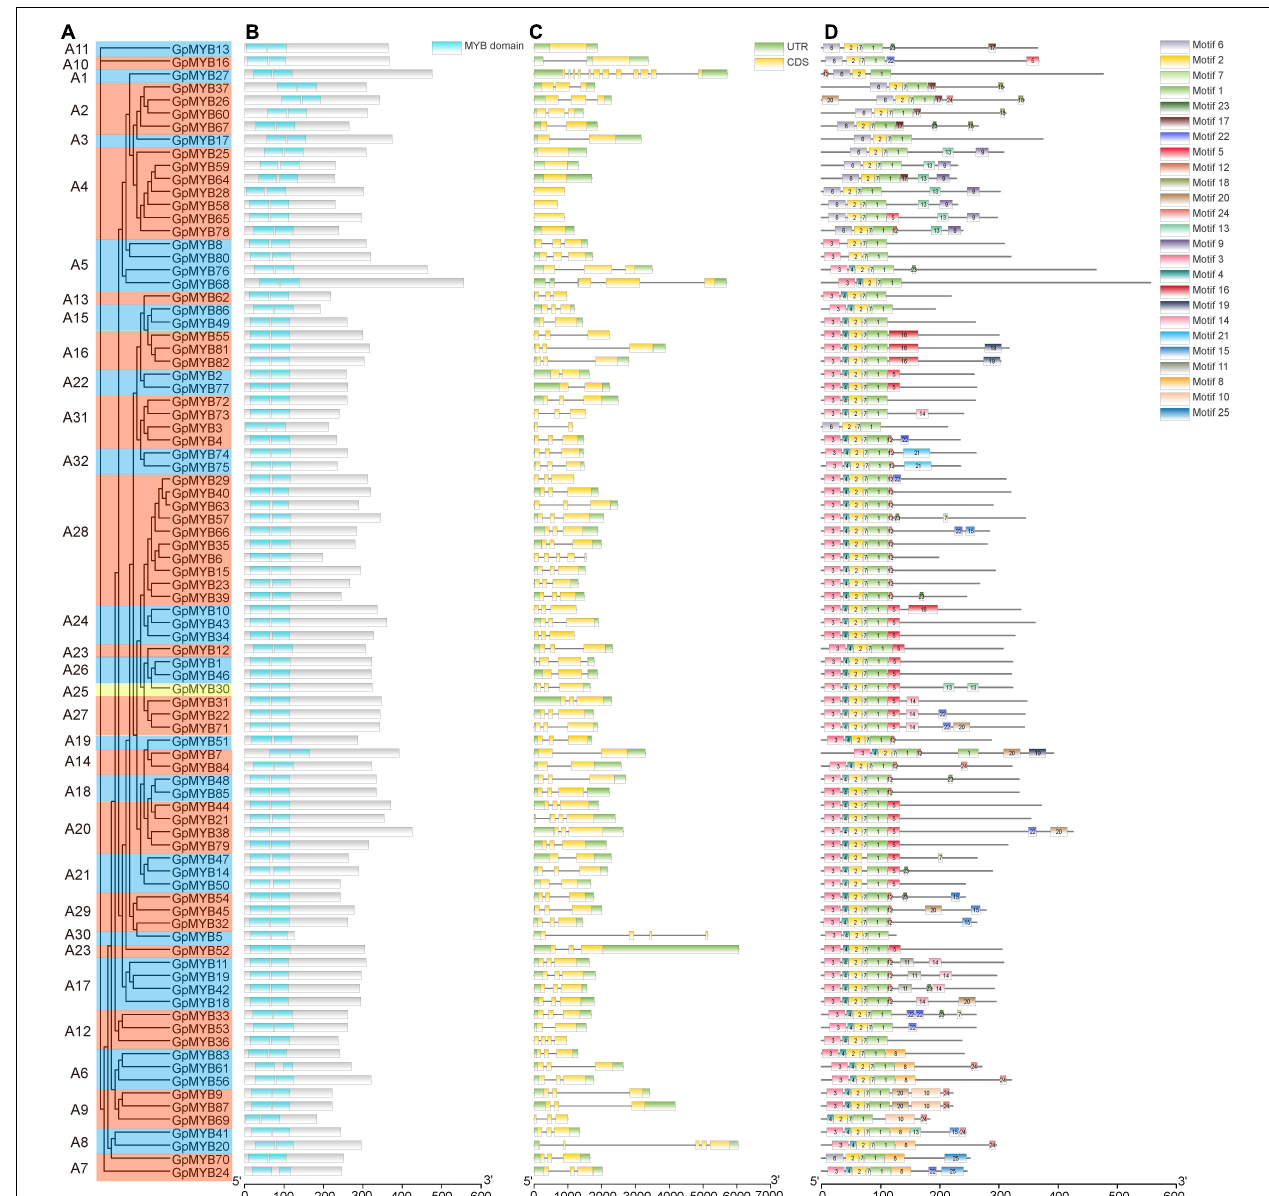
FIGURE 2 | Analysis of conserved MYB DNA-binding domains, gene structure, and conserved motifs depending on the phylogenetic relationships in R2R3-GpMYB genes. (A) A phylogenetic tree was built using 87 R2R3-GpMYB proteins with the ML method. The phylogenetic tree contains 32 subgroups represented by different colors. (B) The conserved MYB DNA-binding domains were examined using Pfam and the Simple Modular Architecture Research Tool (SMART). Green boxes indicate conserved MYB DNA-binding domains. (C) Exon/intron structure analysis of R2R3-GpMYB genes. Gray lines, yellow boxes, and green boxes indicate introns, exons, and untranslated regions (UTRs), respectively. (D) Conserved motifs of R2R3-GpMYB genes elucidated by Multiple Expectation maximizations for Motif Elicitation (MEME). The conserved motifs are represented by the different colored boxes. The scale bar of each R2R3-GpMYB gene is shown at the